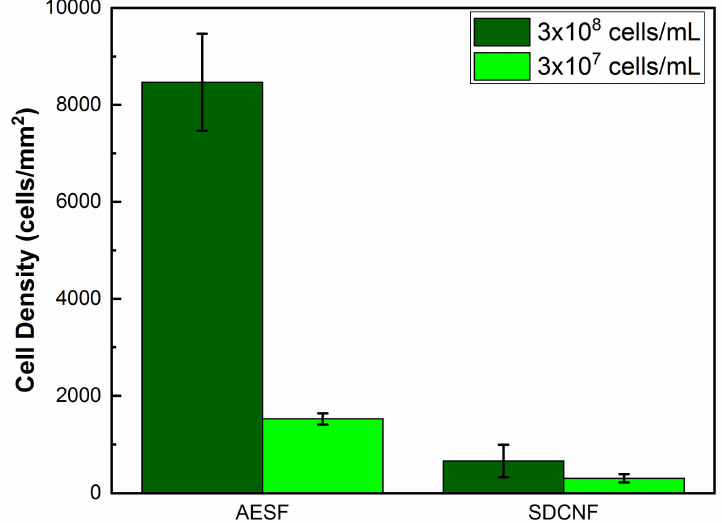
Figure8. Capturecelldensityofanti- E.coli